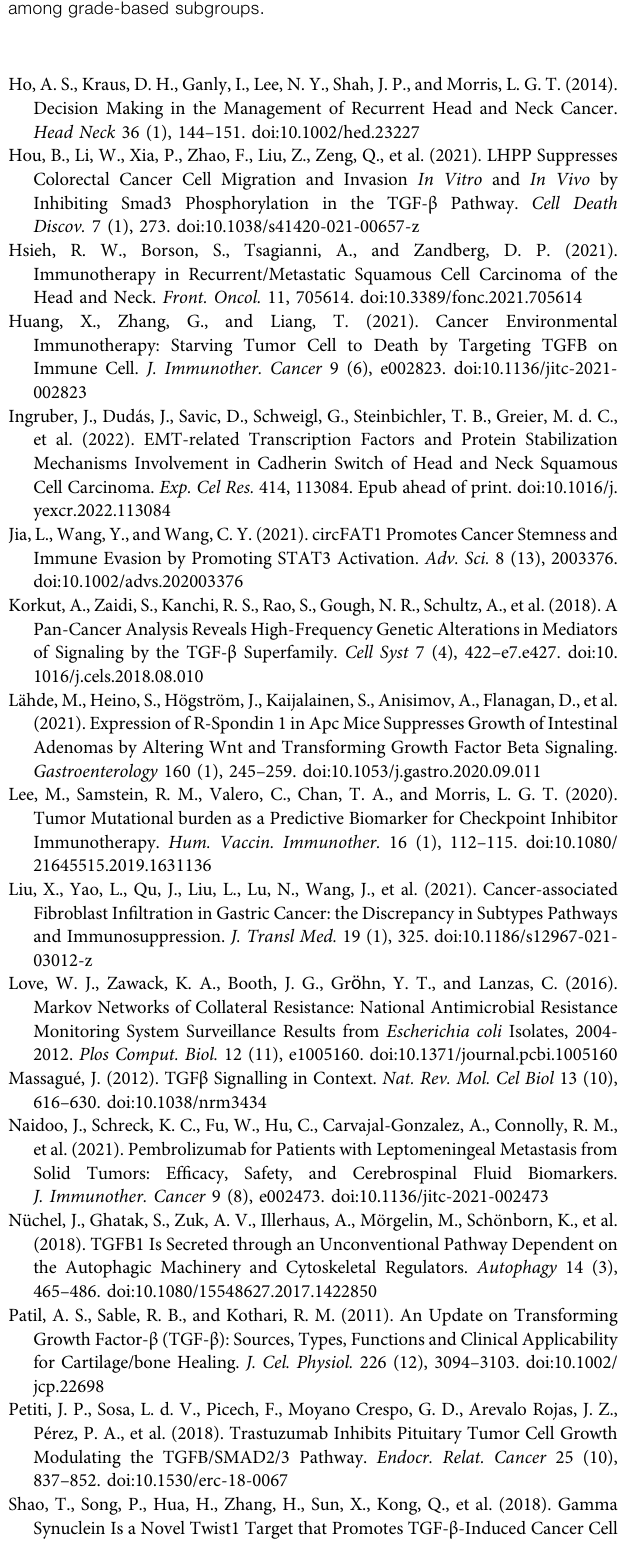
SupplementaryFigureS1| Comparisons of risk scores among clinical features. (A) Comparison of risk scores among T stage-based subgroups. (B) Comparison of risk scores among N stage-based subgroups. (C) Comparison of risk scores among M stage-based subgroups. (D)